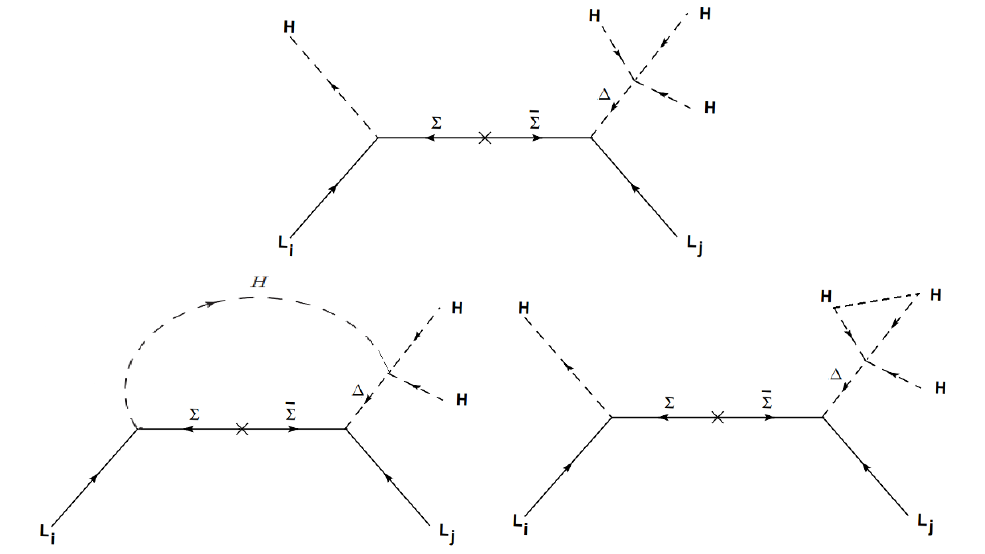
Figure 2 . Top: tree level diagram generating dimension-7 seesaw operator; Bottom: 1-loop dia- grams generating dimension-5 operator for neutrino